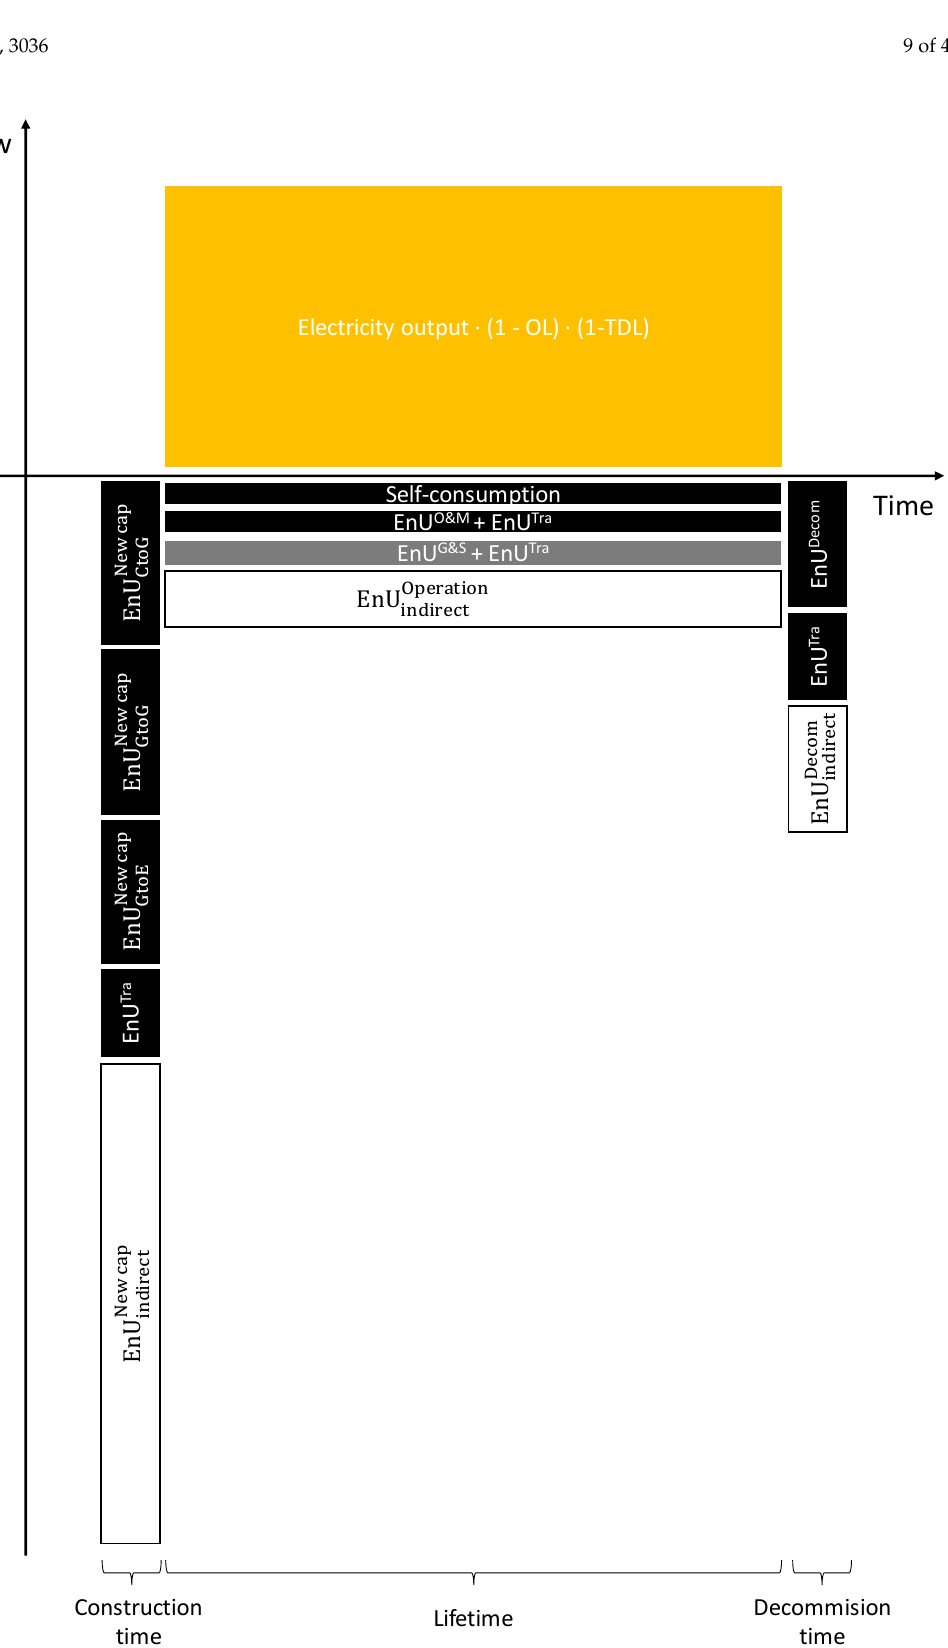
Figure 3. Conceptual representation of the energy inputs and output for power plants for variable renewable electricity generation and storage facilities. Black boxes represent energy investments considered at the EROI st phase, grey boxes the additional features incorporated into the EROI final , and the white boxes the indirect investments to compute the EROI ext . Adapted from [3], not to